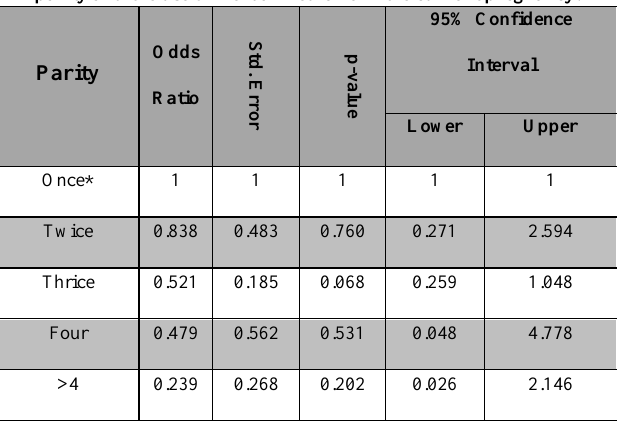
Table 7. Logistic regression showing the level of relationship between parity and the use of Herbal medicine in the current